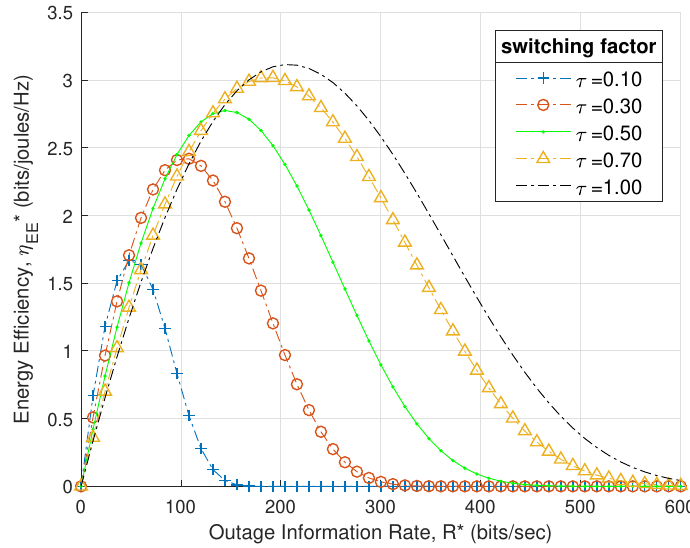
Figure 11. EE vs. outage information rate in TS